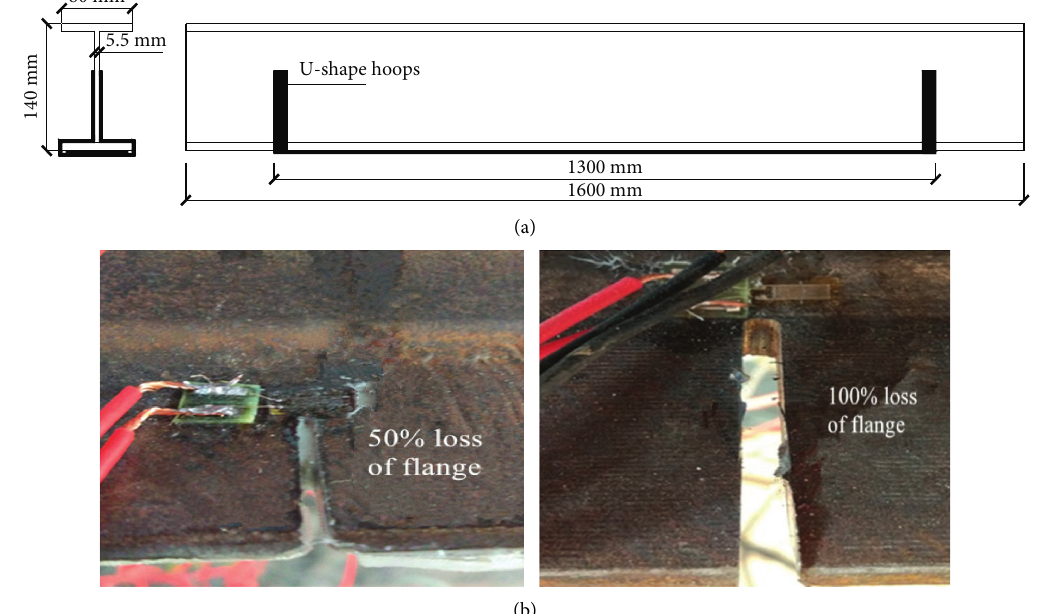
Figure 1: The preparation of specimens. (a) Dimension and strengthened method. (b) Damaged